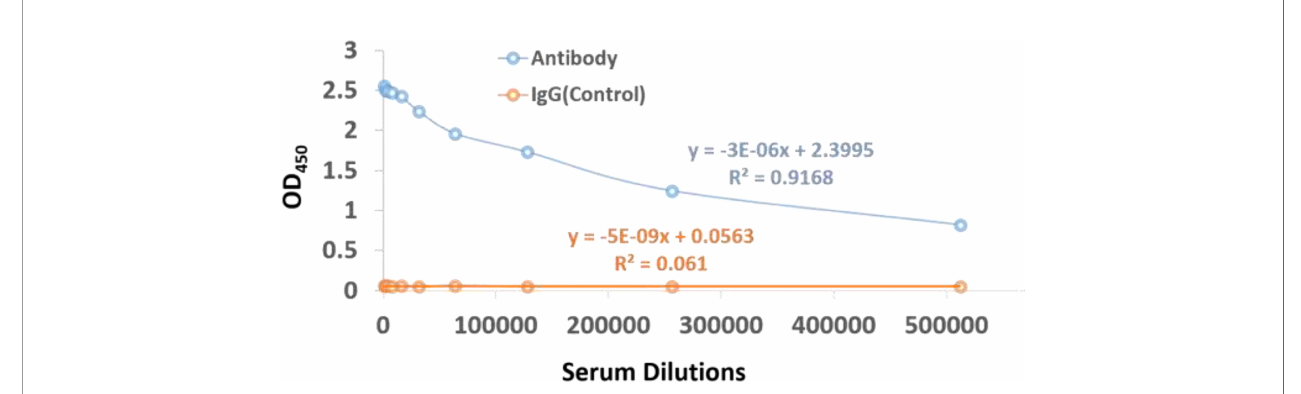
FIGURE 6 | ELISA assay scatter plot of OD 450 values and serum dilutions from (1:1000 to 1:512,000) of dengue virus antibody and IgG control with varying concentration of antigen. The OD 450 values can be inversely correlated to the